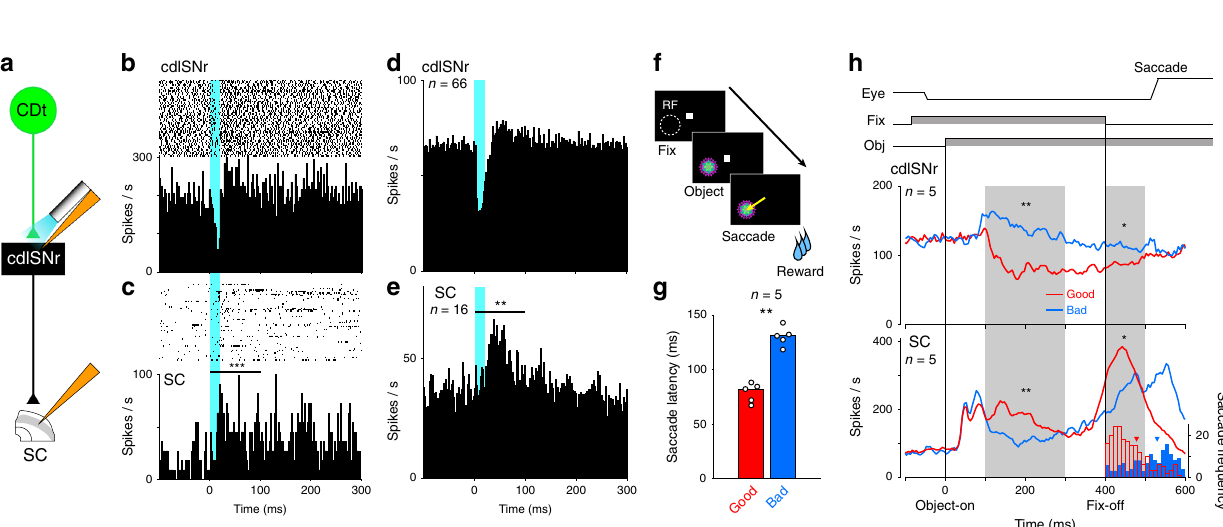
Fig. 4 Inhibition of stable value-coding GPe neurons by optical stimulation. a Recording from cvGPe during optical stimulation of CDt-cvGPe pathway. b A representative cvGPe neuron showed an inhibitory response to the stimulation ( P = 9.9 × 10 − 8 , Wilcoxon signed-rank test, two-sided). *** indicates P < 0.001. Same format as Fig. 3b. c The same neuron showed signi fi cantly lower responses to bad objects than good in the passive viewing task ( P = 0.0079, Mann – Whitney U test, two-sided). ** indicates P < 0.01. Same format as Fig. 3c. d Average activity of 61 cvGPe neurons showing signi fi cant responses to the stimulation. Same format as Fig. 3d. e Population activity of the 61 neurons showed signi fi cantly higher response to good objects than bad ( P = 0.0067, Wilcoxon signed-rank test, two-sided). ** indicates P < 0.01. Same format as Fig. 3e. f Distribution of the 61 neurons across stable value index. Gray and white histograms indicate signi fi cant value-coding ( P < 0.05, Wilcoxon signed-rank test, two-sided) and non-signi fi cant neurons ( P > 0.05, Wilcoxon signed-rank test, two-sided), respectively. g Average activity of 17 neurons that did not show signi fi cant responses to the stimulation. h Population activity of the 17 neurons to objects showed no signi fi cant difference between good objects and bad objects ( P = 0.52, Wilcoxon signed-rank test, two-sided). N.S. indicates P > 0.05. i Distribution of the 17 neurons across stable value index. Gray and white histograms indicate signi fi cant value-coding ( P < 0.05, Wilcoxon signed-rank test, two-sided) and non-signi fi cant neurons ( P > 0.05, Wilcoxon signed-rank test, two-sided), respectively. j Localization of stimulation-responsive neurons in cvGPe. Same format as Fig. 3j.